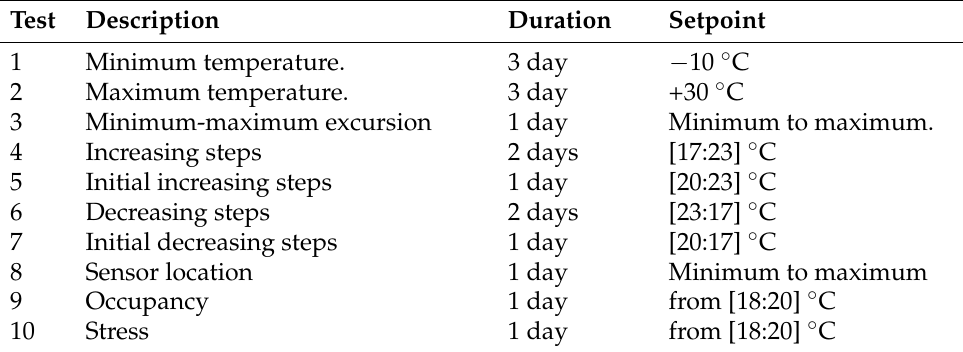
Table 2. Heating system schedule